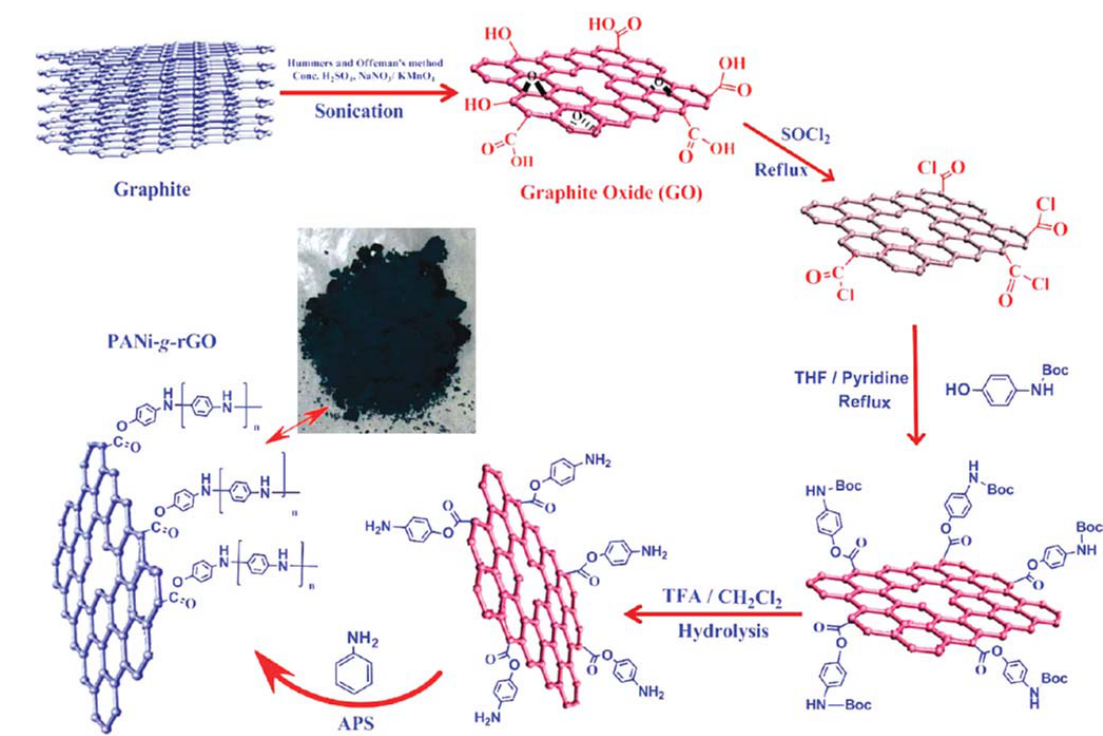
Figure 11. Schematic illustration of the formation process of polyaniline-grafted graphene composites. Reprinted with permission from [33]. Copyright 2012 American Chemical